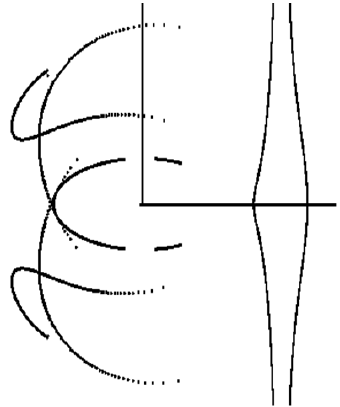
Figure 9. q = 1, KG = 100, and DK = 200.